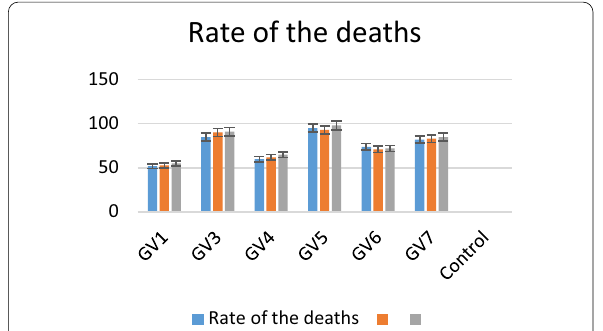
Fig. 4 Miticidal effects of bacteria against V. destructor